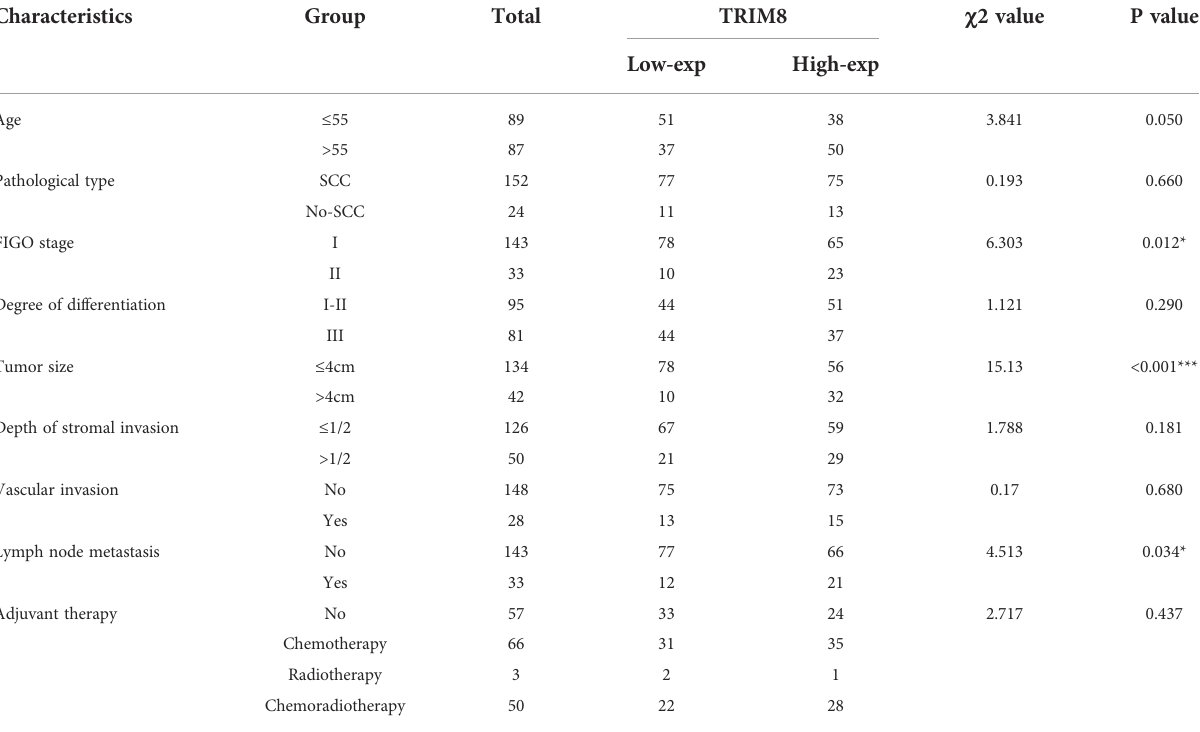
TABLE 1 Relationship between TRIM8 and clinical characteristics of cervical